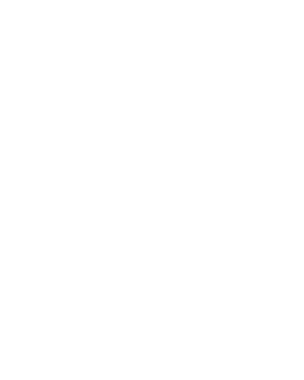
FIGURE 5 | Detection of serum speci fi c antibody levels by ELISA. Levels are indicated using OD450 values and presented as mean ± SD. A comparison the L. lactis pNZ8148- VP6 group and the PBS group is shown. *p <